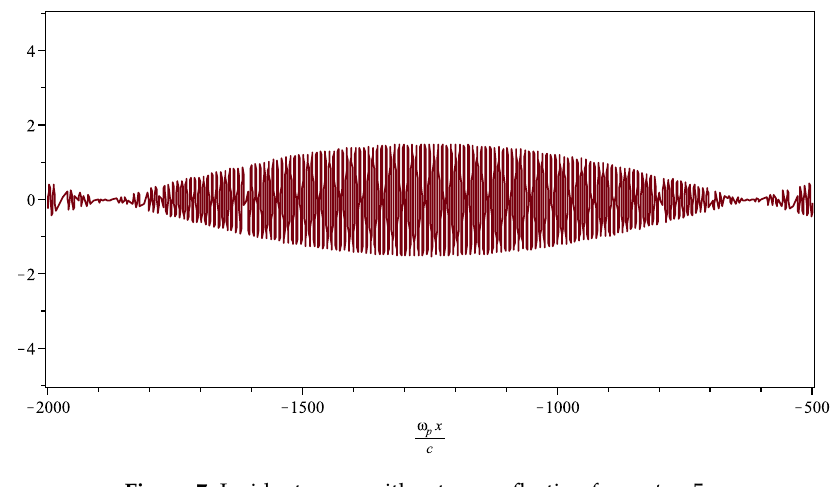
Figure 7. Incident wave without any reflection for ω p t =